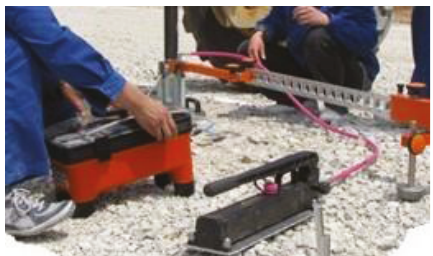
Figure 11: Static deformation modulus test ( E